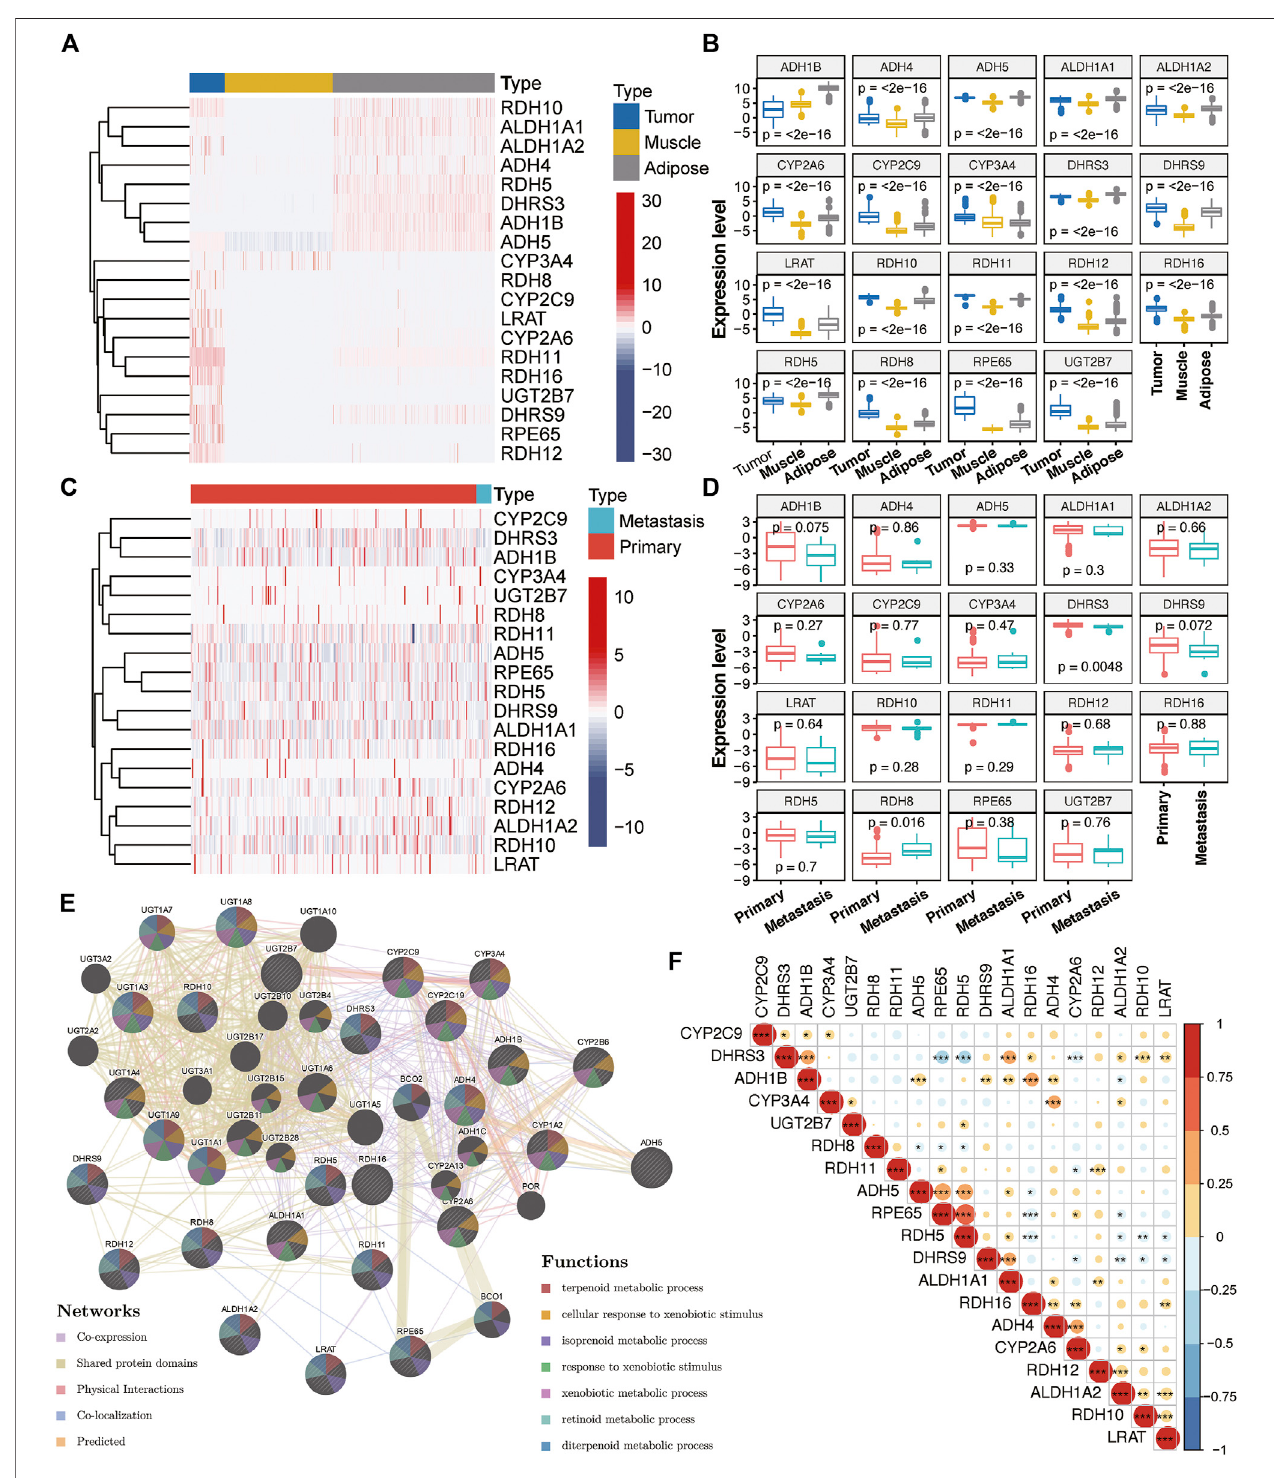
FIGURE 1 | Expression of RA metabolism-related enzymes in SARC. Heatmap (A) and boxplot (B) of expression levels of the RA metabolism-related enzymes (normal sample vs. tumor sample). Heatmap (C) and boxplot (D) of expression levels of the RA metabolism-related enzymes (primary sample vs. recurrent sample) (E) PPI network and pathway analysis of the RA metabolism-related enzymes (F) Spearman correlation analysis of the RA metabolism-related enzymes.